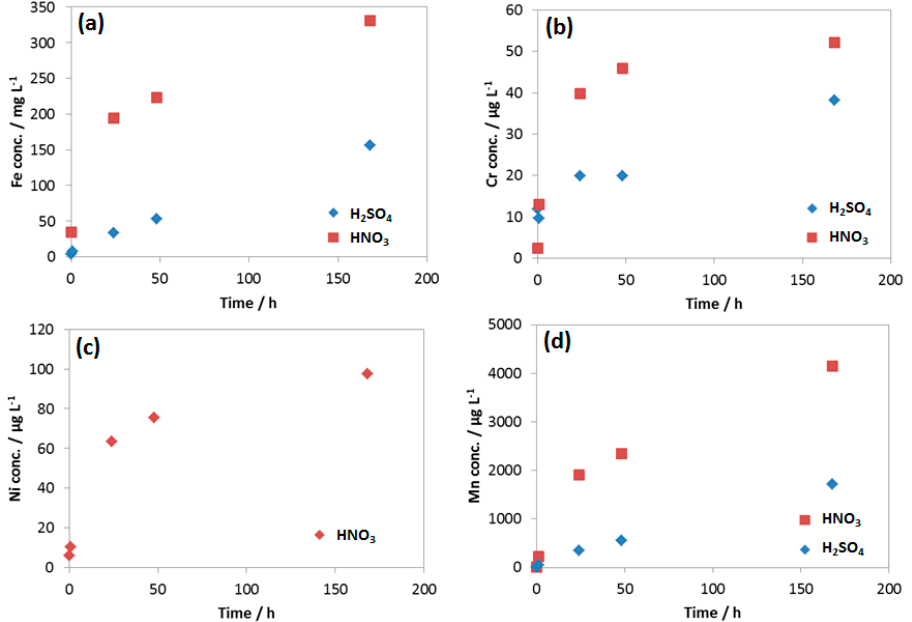
Figure 14. Concentration of ( a ) Fe; ( b ) Cr; ( c ) Ni and ( d ) Mn in the reacted 0.0184 M HNO 3 and 0.114 M H 2 SO 4 condensates.